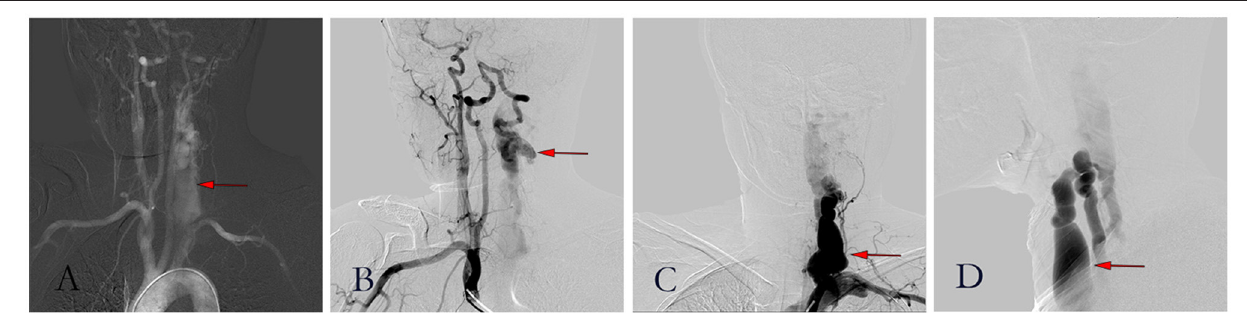
FIGURE 4 | Figures of digital subtraction angiography. (A) Angiography showed a large area of the left vertebral artery; (B) Brachiocephalic trunk angiography showed a large flow of blood from the right vertebral artery through a circle of Willis to the left; (C) Posterior-anterior image of left vertebral arteriogram; (D) Lateral image of left vertebral arteriogram.